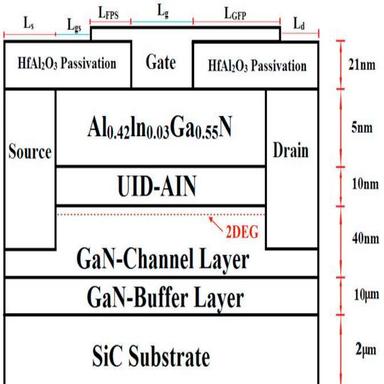
Schematic cross sectional view of the device with a polarization Quaternary Barrier Material QB-MIS-HEMT of Al0.42ln0.03Ga0.55N and high-κ HfAl2O3 insulator used for numerical device simulation; Lg, LGFP, Lgs and Lgd are the gate length, gate field plate to gate access region lengths, the gate length and the length of the gate to drain.